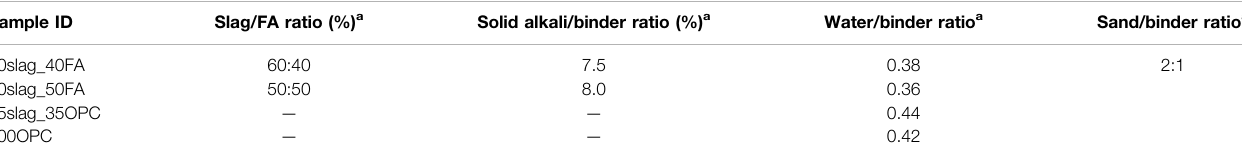
TABLE 2 | Mix proportions of AASF and OPC mortars. Sample